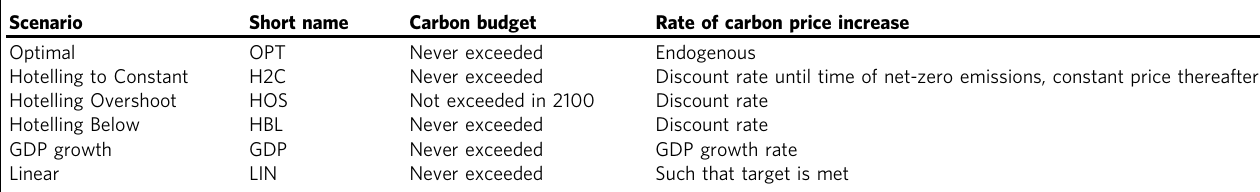
Table 1 Scenario de fi